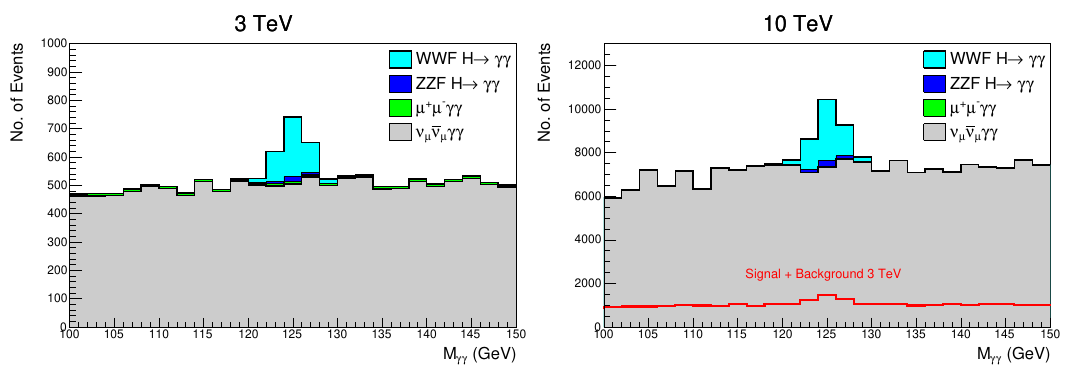
Figure 6 . Stacked γγ pair invariant mass histograms for the H → γγ analysis after cuts at (left) 3 TeV and (right) 10 TeV. The sum of signal and background at 3 TeV is overlayed on the 10 TeV for ease of